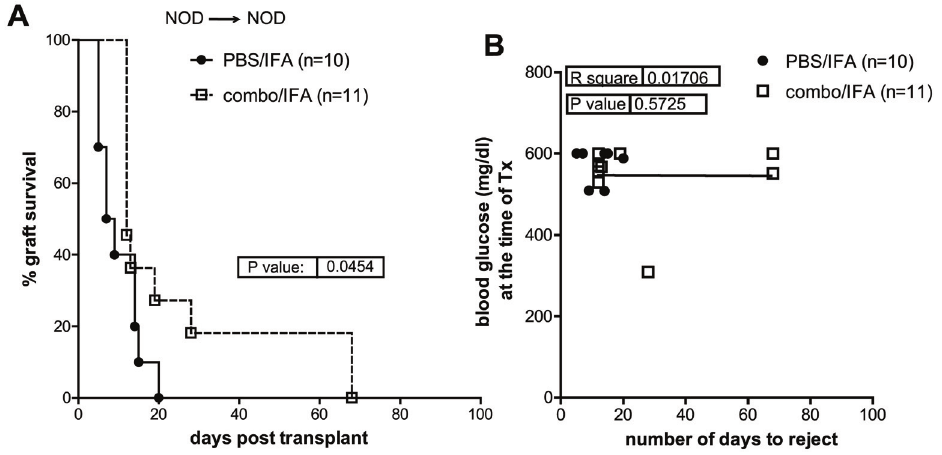
Fig 3. Combination therapy with InsB 9 – 23 , IGRP 206 – 214 and GAD 524 – 543 is less efficacious in promoting syngeneic islet transplant tolerance in NOD mice. A, diabetic NOD mice were transplanted with syngeneic islets. Recipients were treated with a mix of 3 islet peptides, insB 9 – 23 , IGRP 206 – 214 and GAD 524